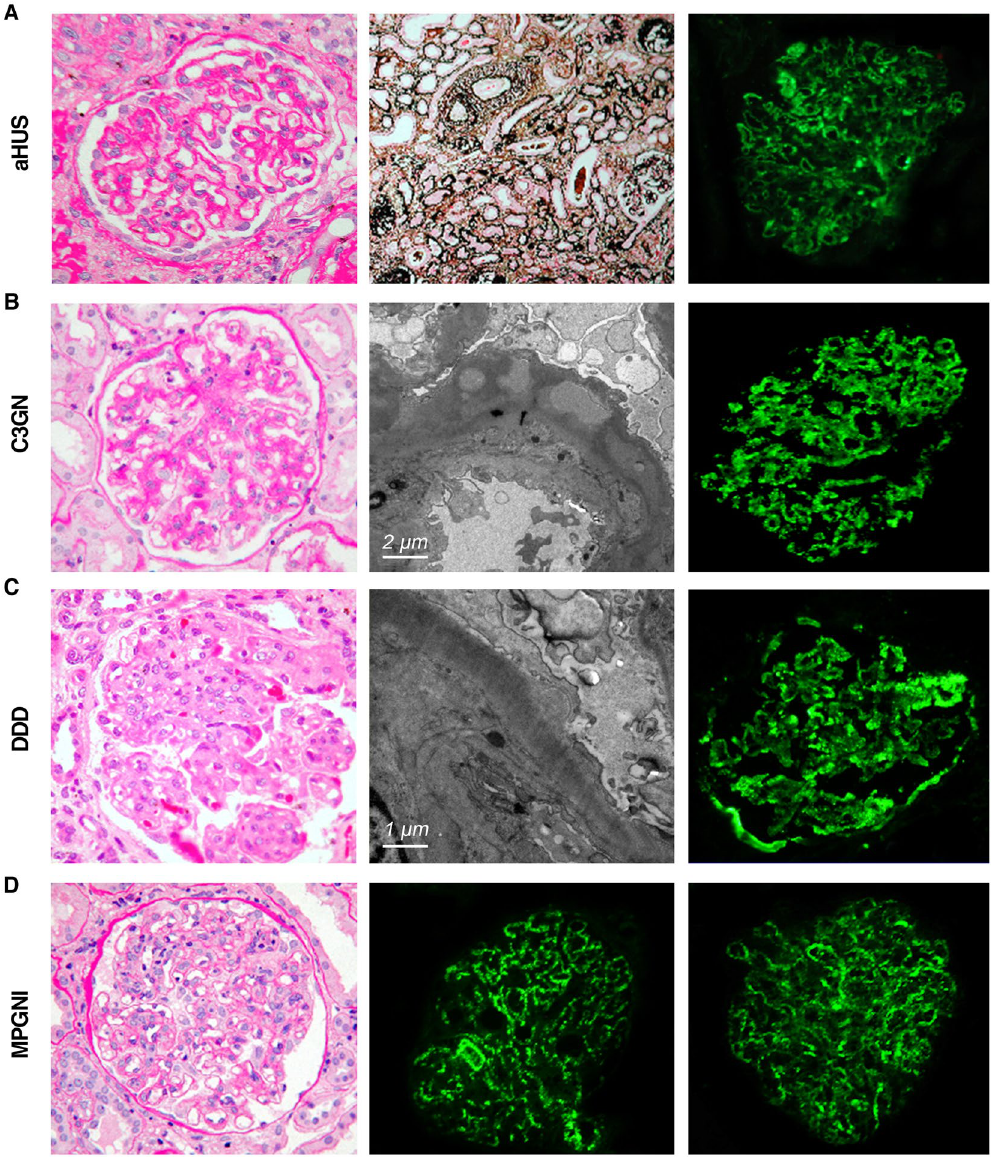
Figure 1. Representative light, electron microscopy and immunofluorescence in cases of aHUS, C3GN, DDD and MPGNI, respectively. The aHUS patient demonstrated a mild mesangial proliferation and arterial thrombotic microangiopathy (TMA) with obliteration of capillary lumina under the light microscope. The C3GN patient showed a moderate to severe mesangial proliferation by light microscope, as well as subepithelial and intramembranous electron-dense deposits by electron microscopy. The DDD patient displayed diffuse endothelial and mesangial cell proliferation with hyaline thrombus formation in capillary loops in the light microscope and ribbon-like high electron-dense intramembranous deposits in the electron microscopy. The MPGN I patient exhibited a moderate mesangial proliferation and diffuse endothelial cell proliferation under the light microscope. A marked C3 staining was detected to locate along the capillary wall or mesangium by immunofluorescence analysis among all of them, with dominant IgG deposition along the capillary wall in the patient with